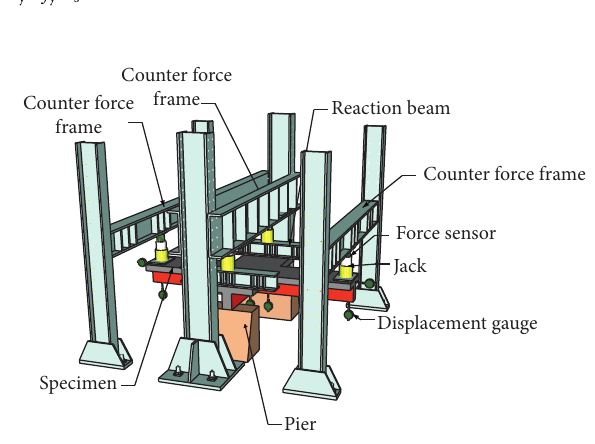
Figure 5: Test setup.